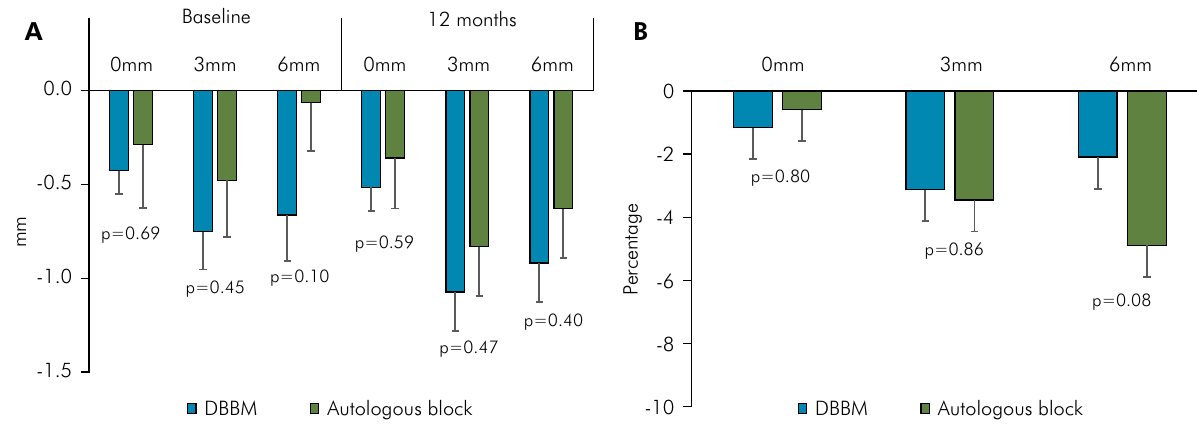
Figure 2. (A) Difference (mm) between the implant site and the contralateral tooth in facial-palatal ridge thickness at baseline and 12 months after crown installation at three different distances from the free gingival margin. (B) Percentage change in the facial- palatal ridge thickness (FPT) at implant site from baseline to 12